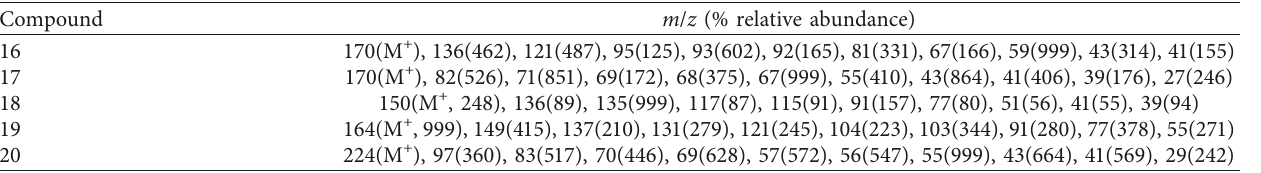
Table 18: Mass spectra of compounds 16–20 of whole plant n -hexane fraction of Achillea wilhelmsii (WHFAW). Compound m / z (% relative abundance)